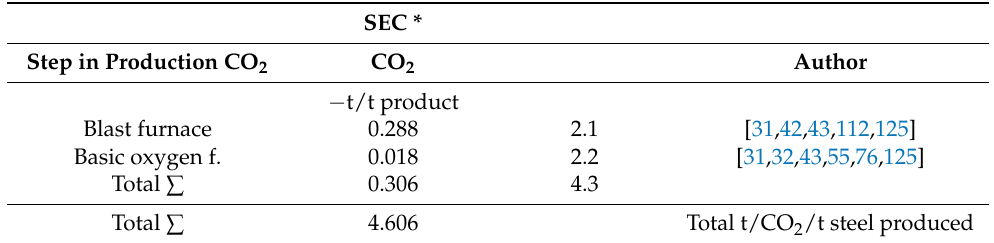
Table 1. CO 2 emissions BF/BOF